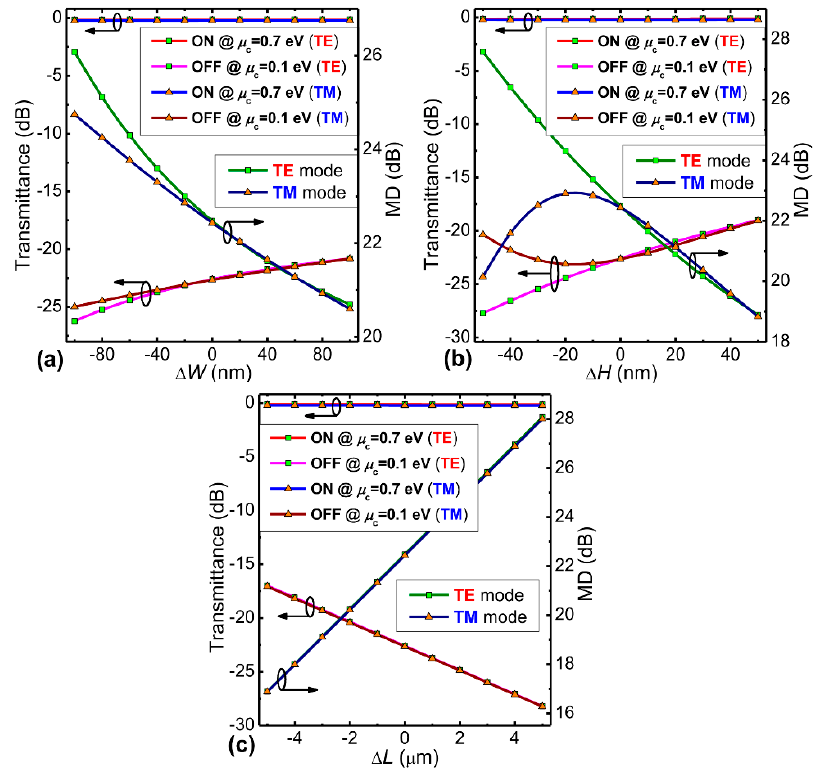
Figure 8. Fabrication tolerance analyses. Transmittance and MD of the proposed modulator as its total ( a ) width W , ( b ) thickness H , and ( c ) length L deviate from their designed values at the “ON” and “OFF” states for both polarizations, where the size deviations of waveguide width and thickness are assumed to be evenly distributed in every hybrid graphene-silicon waveguide layer.